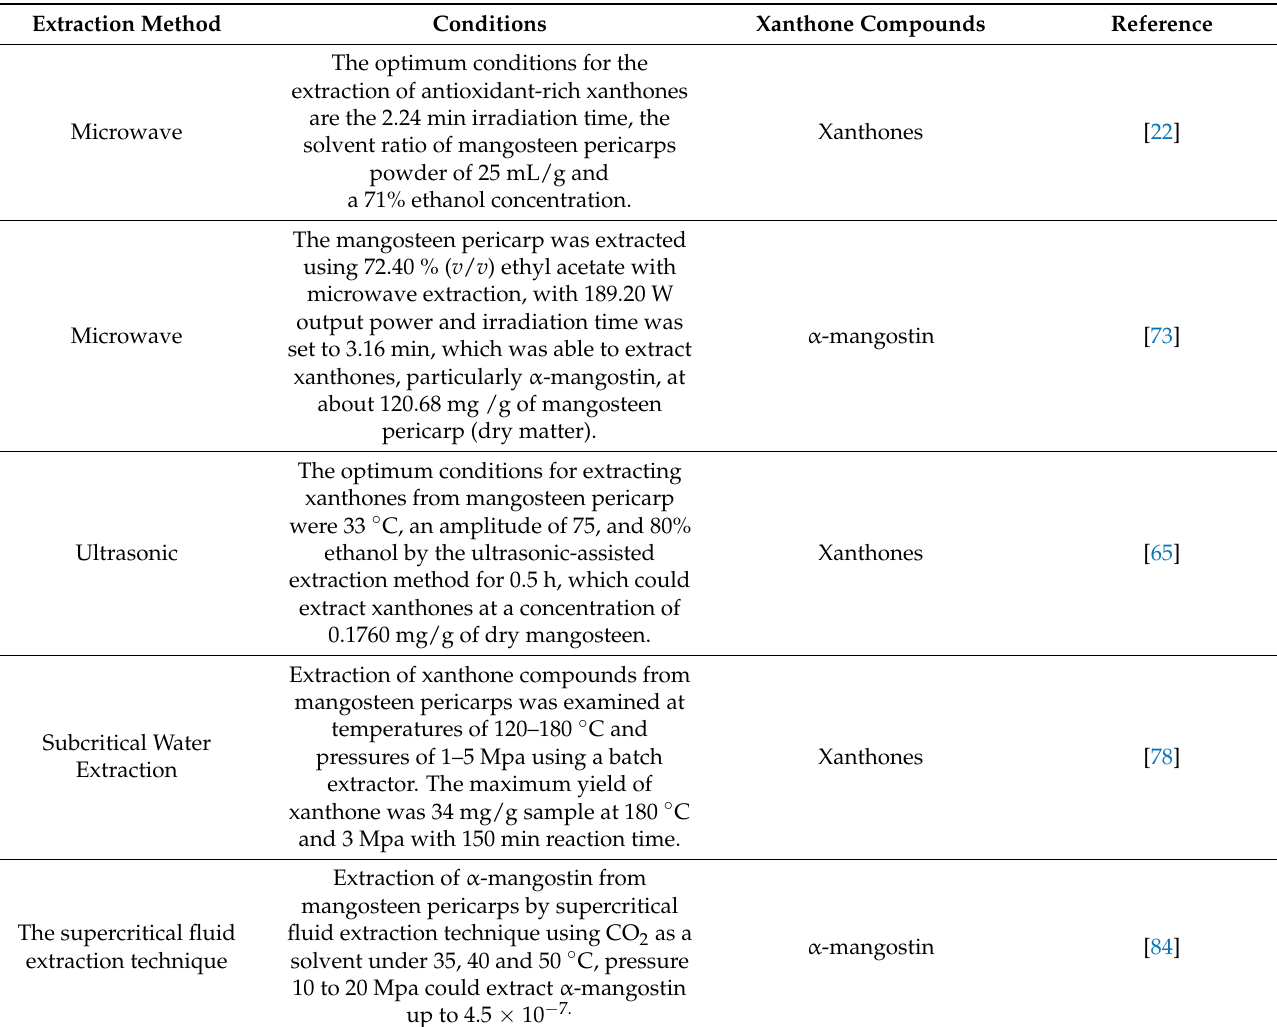
Table 4. A comparison of xanthones and α -mangostin content from the mangosteen pericarp extract by modern extraction